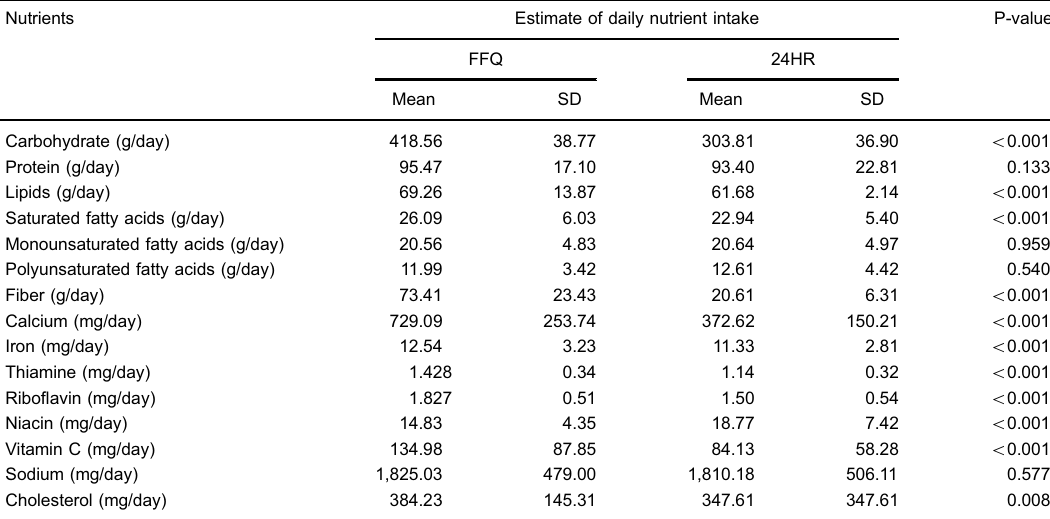
Table 1. Estimated nutrient intake with the 24-hour recalls (24HRs) and the food frequency questionnaire (FFQ). Nutrients Estimate of daily nutrient intake